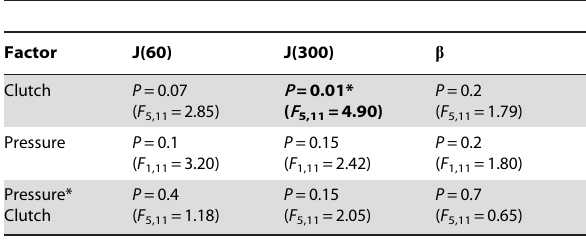
Table 2. ANCOVA table. Loading pressure vs. viscoelastic